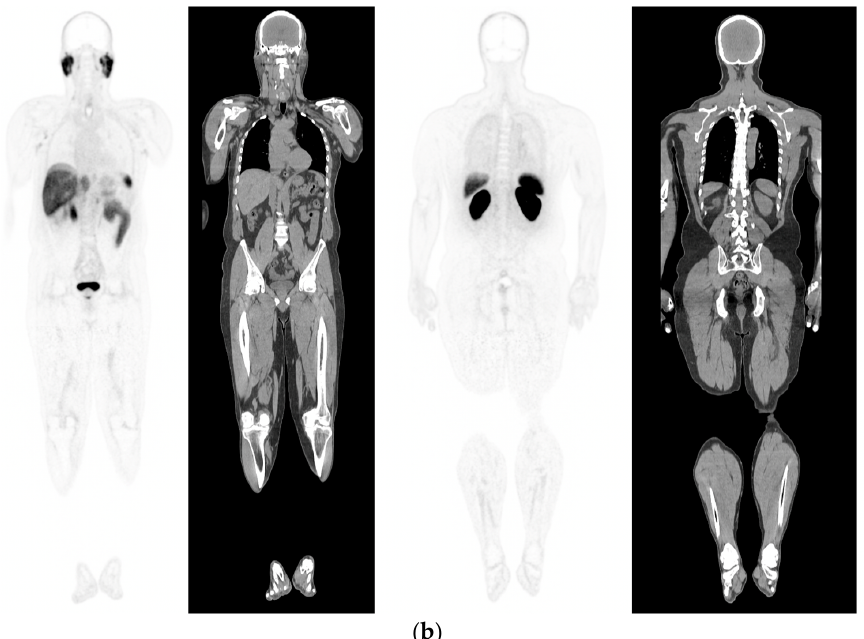
Figure 1. PSMA PET-CT scan showing normal distribution of PSMA-11. 60 yr old M—Gleason 6 prostate cancer on active surveillance for past 2 years; PSA 7.2; MR imaging—low grade changes PIRADS 2. PSMA PET-CT: 68 Ga-PSMA - 204 MBq; uptake 52 min; BMI = 29.7; Wt 90 Kg; coronal PET and corresponding CT slices (soft tissue windows) from left to right. ( a )—physiological uptake in lacrimal, submandibular salivary glands, parotid glands, retropharyngeal soft tissue, liver, bowel, part of spleen and pooling of tracer in bladder; mild reactive tracer uptake in groin and axillary nodes. ( b )—physiological uptake in head and neck; reactive uptake axillary nodes; focal uptake in apex of prostate gland anterior below the bladder SUV = 9.1; marked uptake/excretion of tracer in both kidneys.